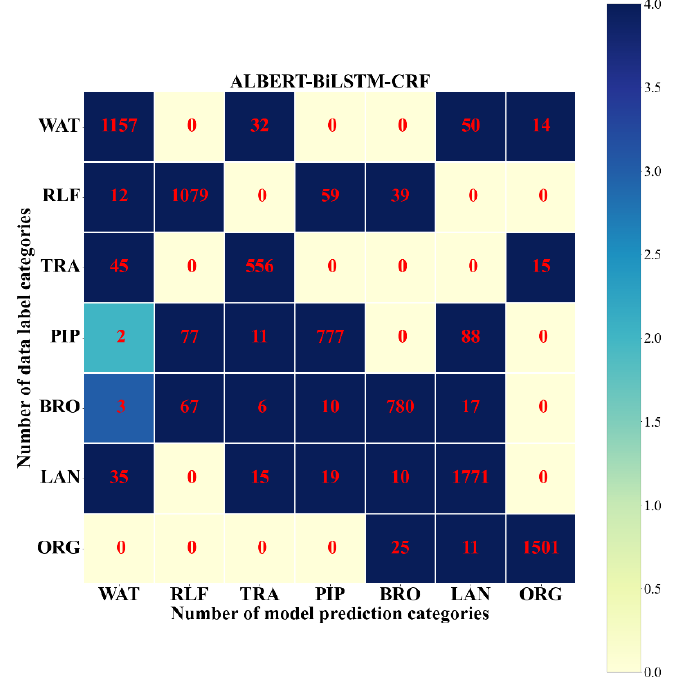
Figure 9. Confusion matrix for all extracted and gold-standard toponym from the constructed dataset based on ALBERT–BiLSTM–CRF. WAT = water system; RLF = residential land and facilities; TRA = transportation; PIP = pipelines; BRO = boundaries, regions, and other areas; LAN = landforms; ORG = organization.